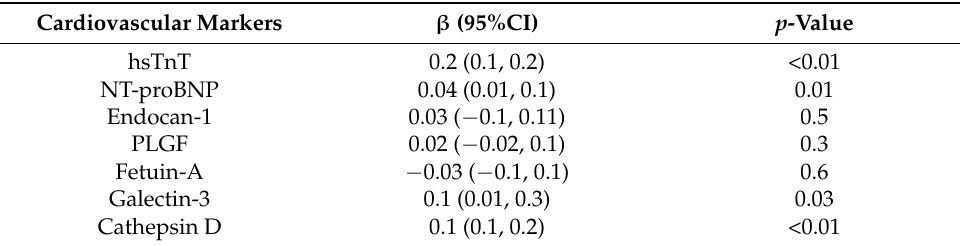
Table 2. Relationship between cardiovascular disease biomarkers and brachial–ankle pulse wave velocity in hemodialysis patients.